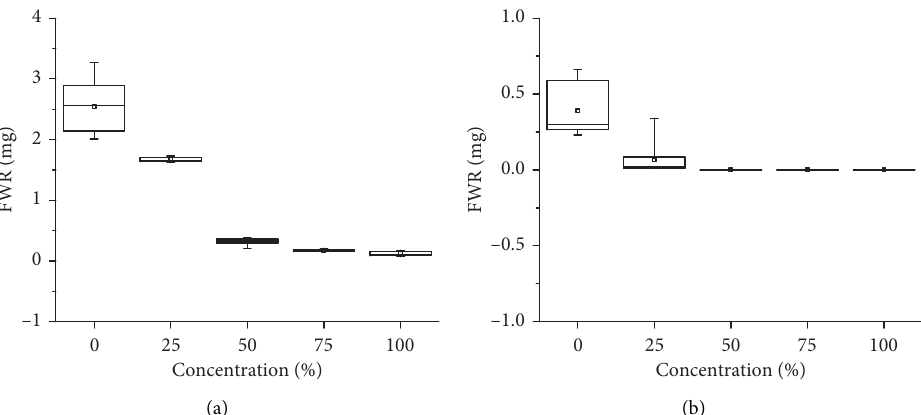
Figure 5: Fresh weight of root (FWR) of germinated P. vulgaris (a) and O. sativa (b) seedlings in laboratory experiment after 7 and 14 days of treatment with S. suaveolens extracts,